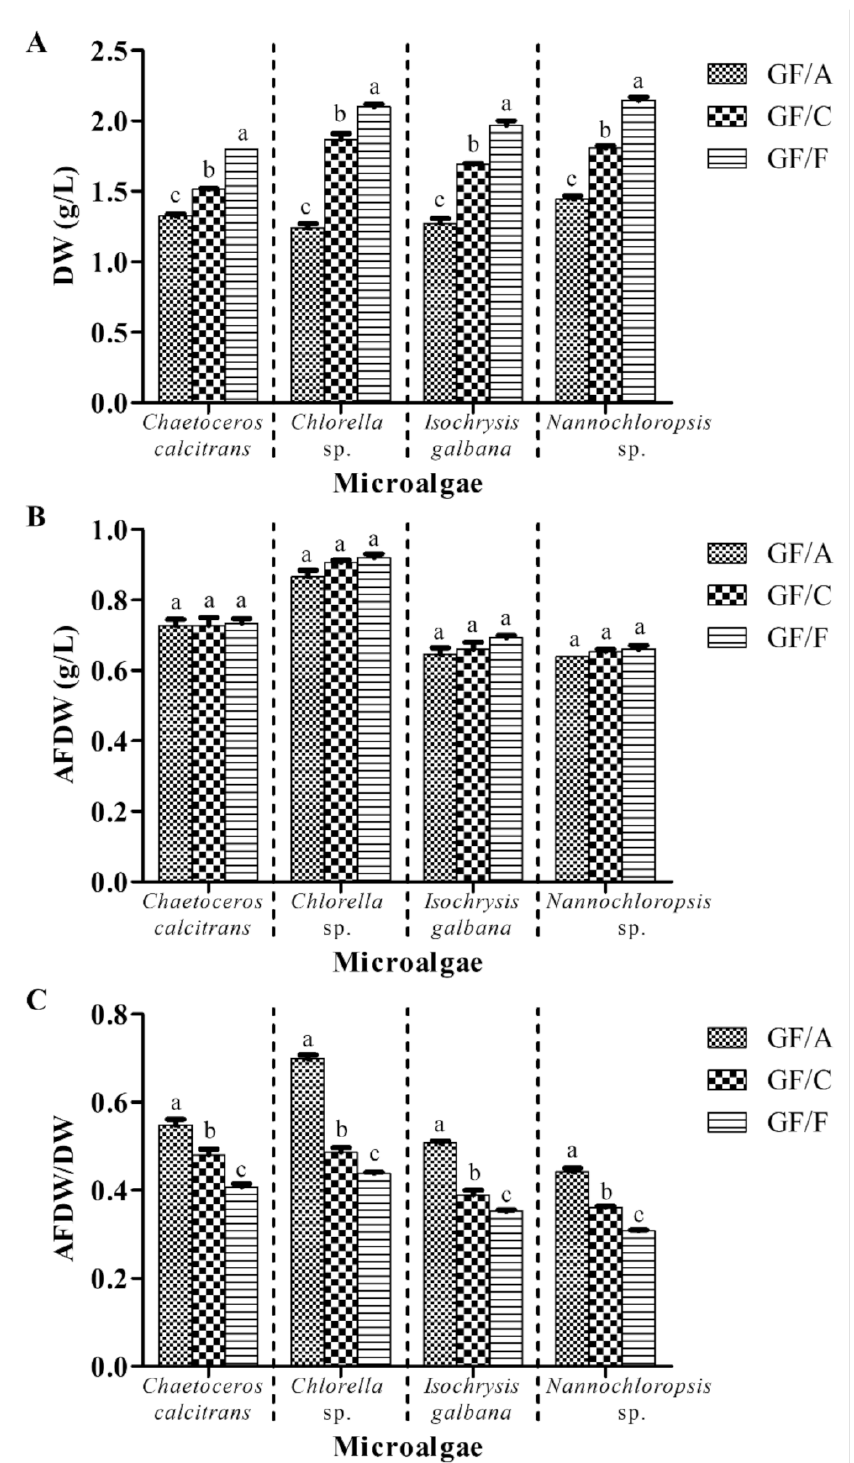
Figure 2. Biomass of four different marine microalgae subjected to different grades of glass microfiber filter. ( A ) dry weight ( B ) ash-free dry weight ( C ) ash-free dry weight/dry weight ratio. The other parameters remained the same (with washing process; pretreatment of GMF at 450 ◦ C for 8 h; 0.5 M ammonium formate; 1:1 culture: washing agent ratio; one washing cycle). Different letters for the respective microalgae indicate statistically significant differences ( p < 0.05) in terms of biomass among different grades of glass microfiber filter. DW, dry weight; AFDW, ash-free dry weight. Data are expressed as mean ± standard error (n =